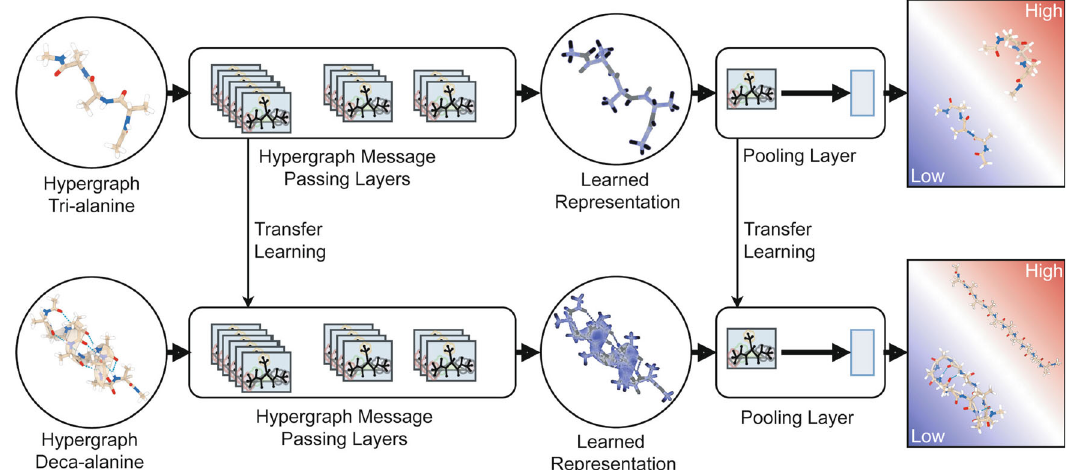
Fig. 1 Transfer learning pipeline. The top part of the fi gure represents the training of the neural network model, where the hypergraph representation of the molecules used for training (e.g., examples of the tri-alanine system) are passed through hypergraph message-passing layers to obtain hidden representations. Such representations are further processed by a pooling layer to output the probability of the input being a low free-energy conformation. The bottom part of the fi gure describes the transfer learning process, where the trained model is used to process examples of the target system (e.g., the deca-alanine system) and make predictions